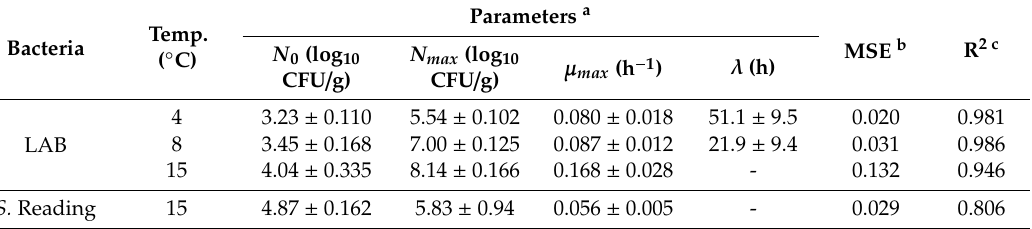
Table 2. Estimated growth parameters for the di ff erent storage